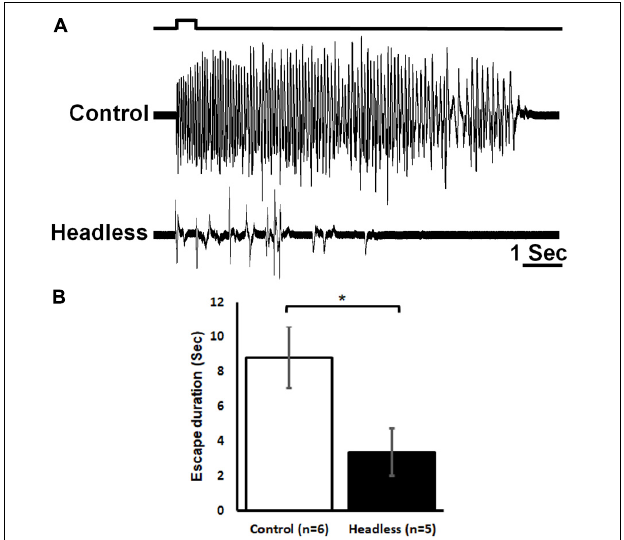
FIGURE 7 | The head ganglia are required for proper escape response to noxious stimuli. (A) Response of control (upper trace) and headless (lower trace) tethered cockroaches to brief (0.5 s) noxious stimuli. (B) The escape response to noxious stimuli of headless cockroaches is reduced as compared to control cockroaches. Bars represent means ± SEM, significance is indicated with asterisk.